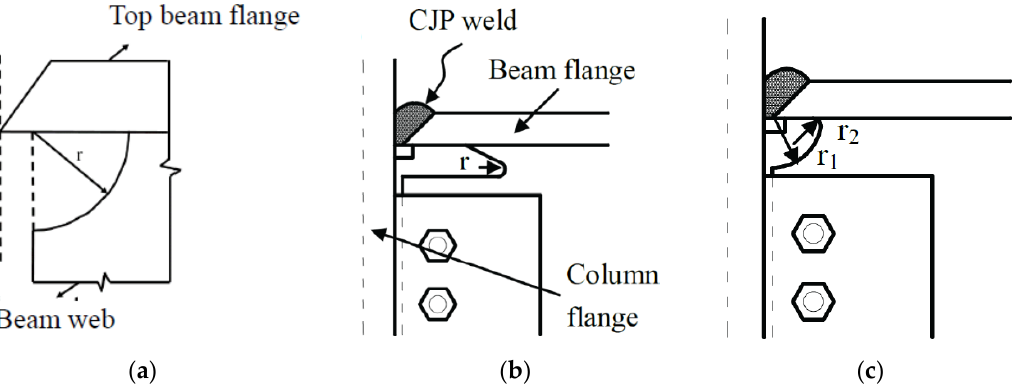
Figure 10. Shapes of weld access holes: ( a ) conventional type (e.g., r = 35 mm, denoted as 35R), ( b ) FEMA-350 improved type, ( c ) JAS improved type I (e.g., r 1 = 35 mm, r 2 = 10 mm, denoted as 35R+10R).